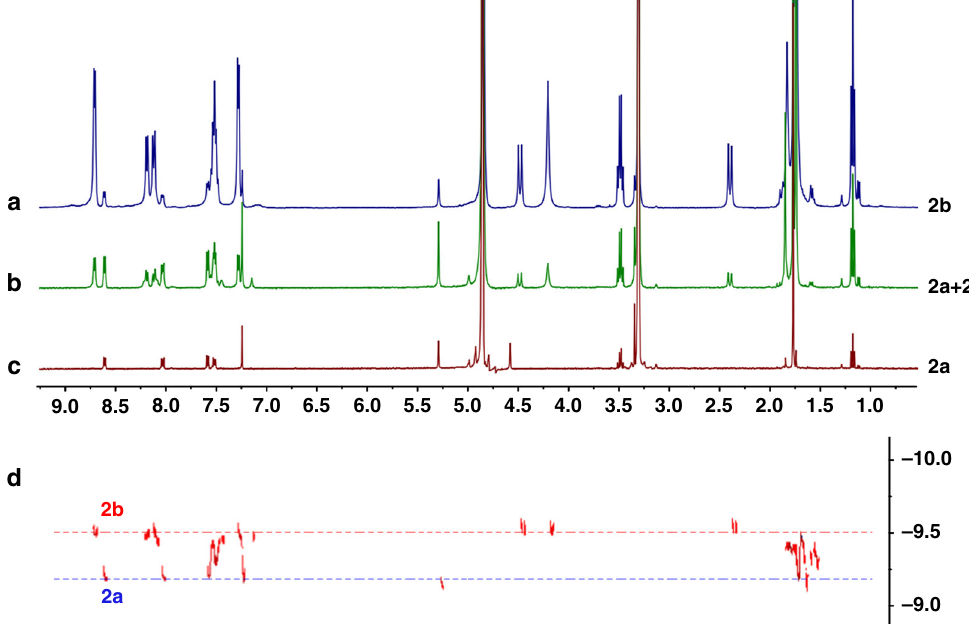
Fig. 3 1 H NMR spectrum (400 MHz, CD 3 OD) of 2b ( a ), 2a + 2b ( b ), and 2a ( c ). DOSY spectrum (500 MHz, CD 3 OD) of 2a + 2b ( d ), (The peaks at 3.50 and 1.18 ppm belong to diethyl